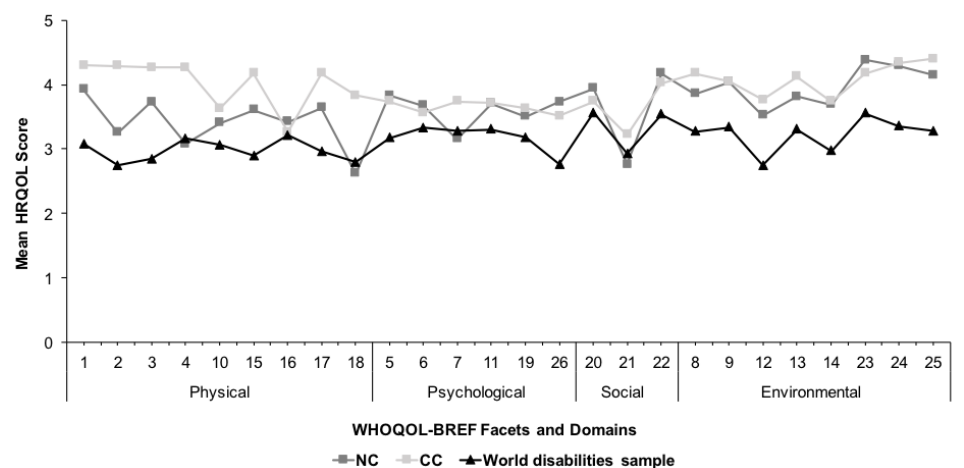
Visual Comparison of HRQOL for the Current Sample and the World Disabilities